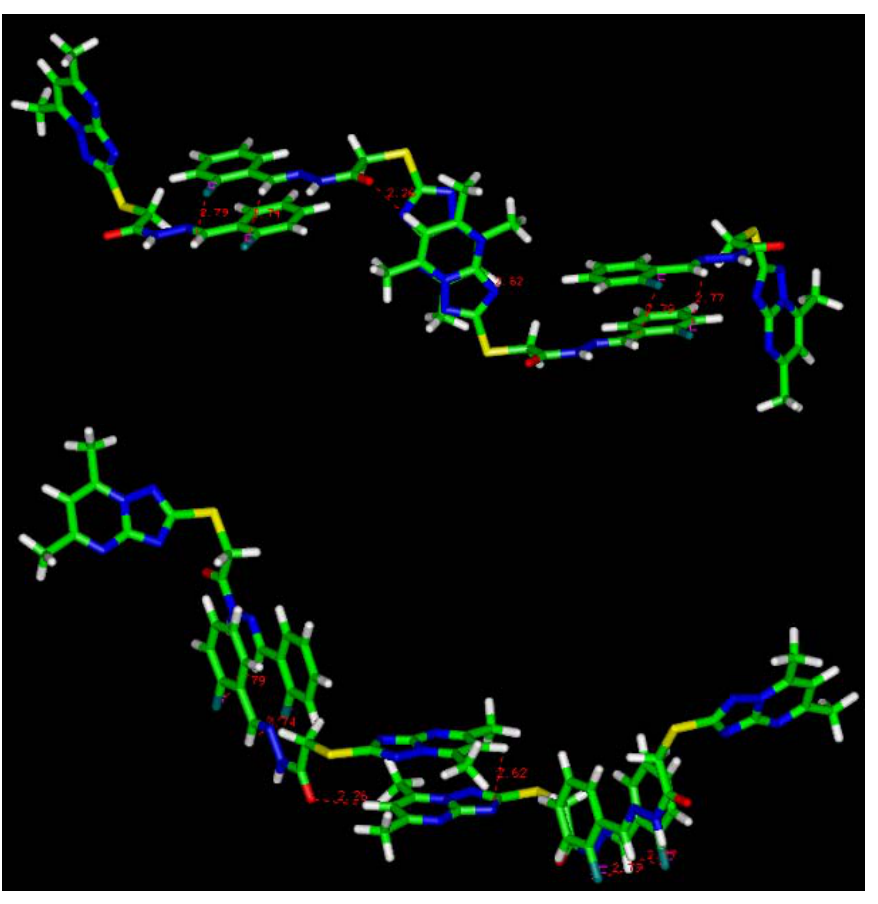
Figure 4. A possible mechanism for the self-assembly of 4a . The hydrogen